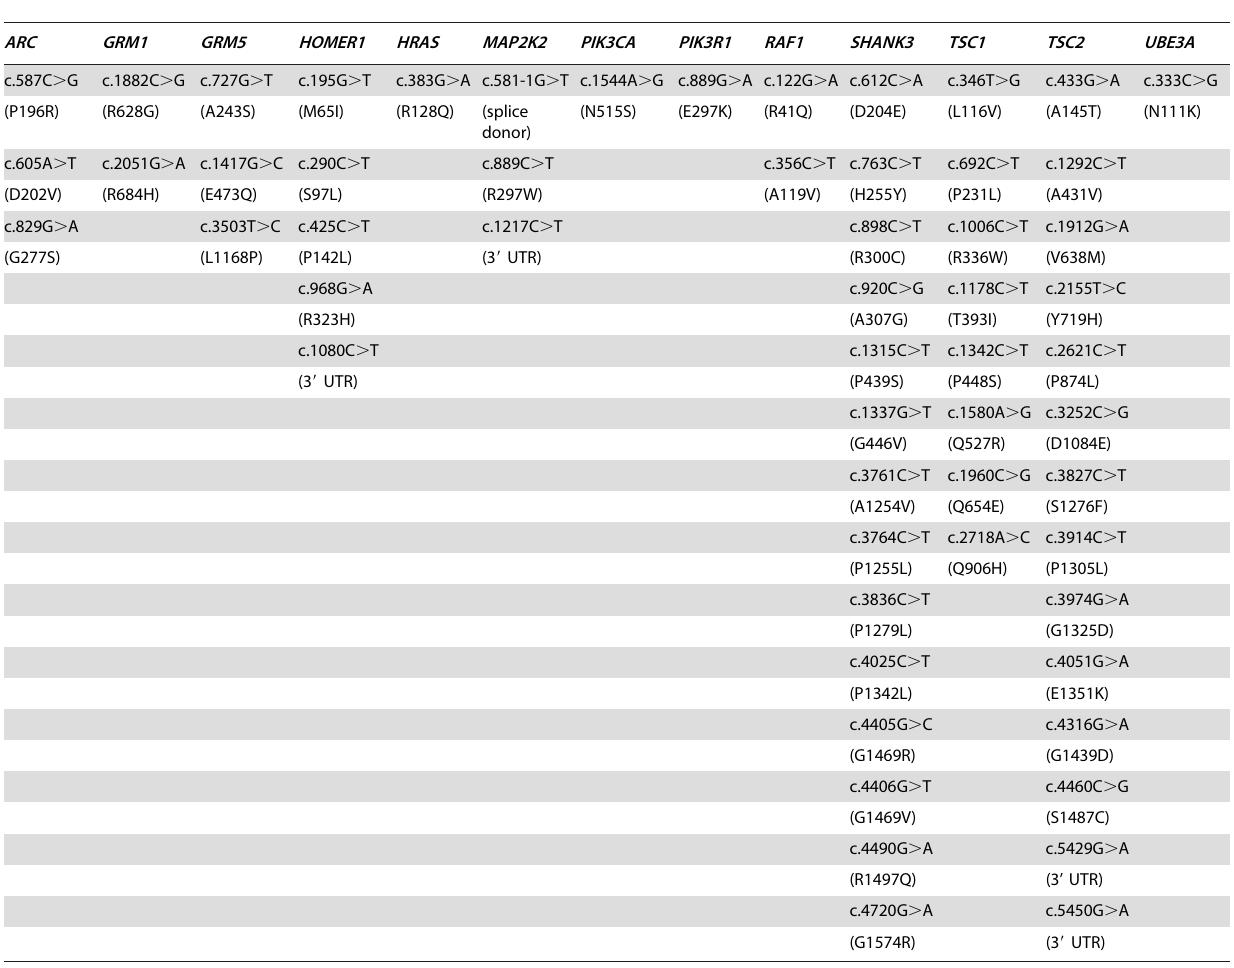
Table 2. Rare, potentially deleterious variants identified in mGluR pathway genes in autism cases.